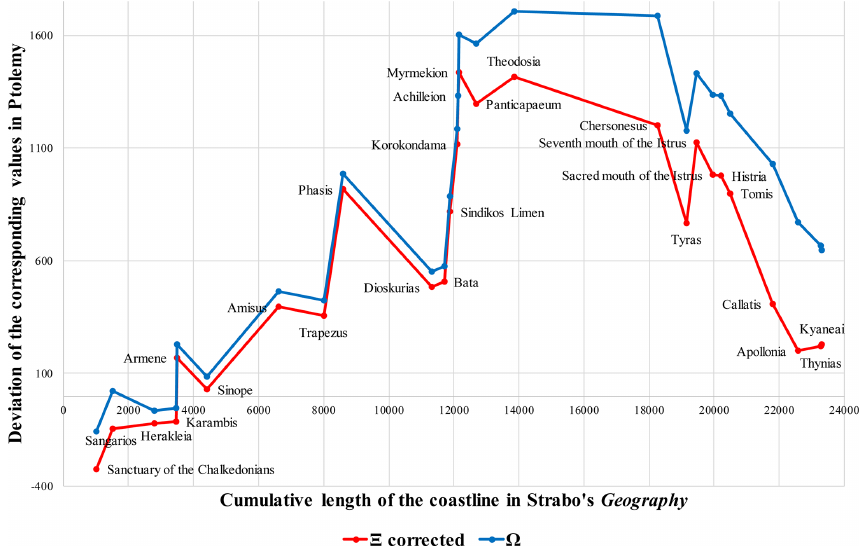
Figure 10. Difference between Ptolemy’s and Strabo’s coastline length data compared geographically. The x axis shows the cumulative sum of the coastal segments in Strabo, measured from the Sanctuary of Zeus anticlockwise around the Pontus. The y axis shows the deviation of Ptolemy’s corresponding sum values from Strabo’s sum values. Upward movement of the graph indicates that Ptolemy stretches the coastline relative to Strabo’s data and vice